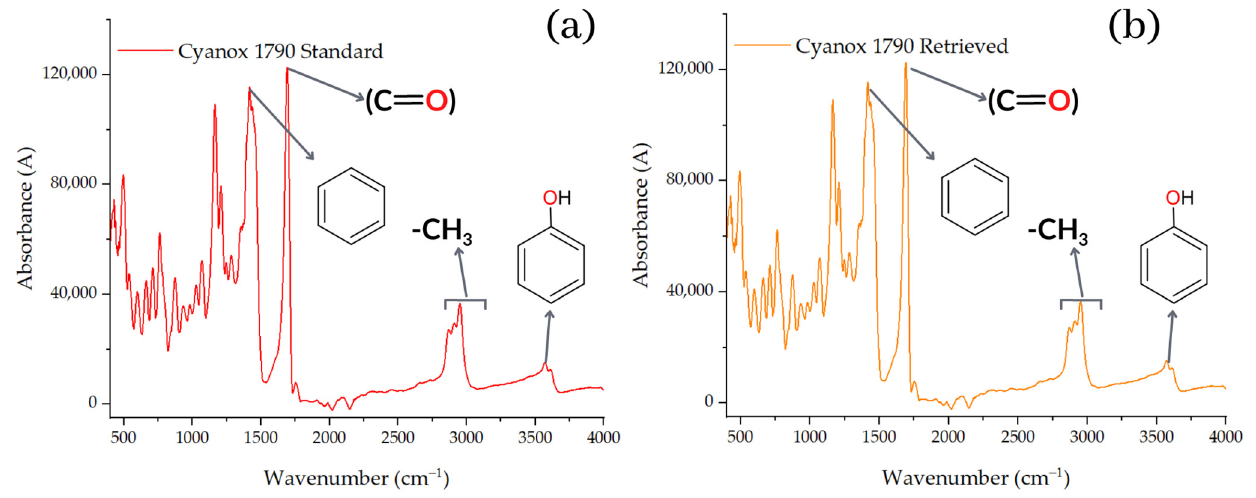
Figure 7. FTIR charts for pure ( a ) and recovered ( b ) Cyanox